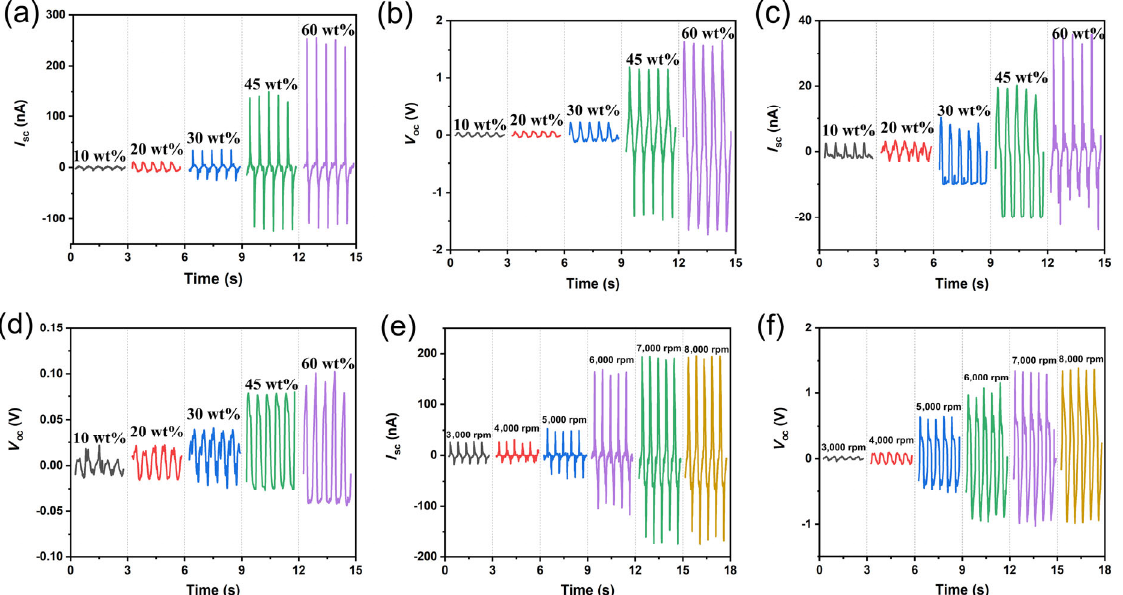
Fig. 4 Effects of substrate structure, concentrations of PTFE dispersion, and PFPE thickness on the output performances of the hydrophobic TENG and SLIPSs TENG devices. (a) I sc and (b) V oc of the OP- (cid:1876) TENG, (c) I sc and (d) V oc of the EP- x TENG with different concentrations PTFE dispersion. (e) I sc and (f) V oc of the y -FOP-60 SLIPSs TENG with different spin